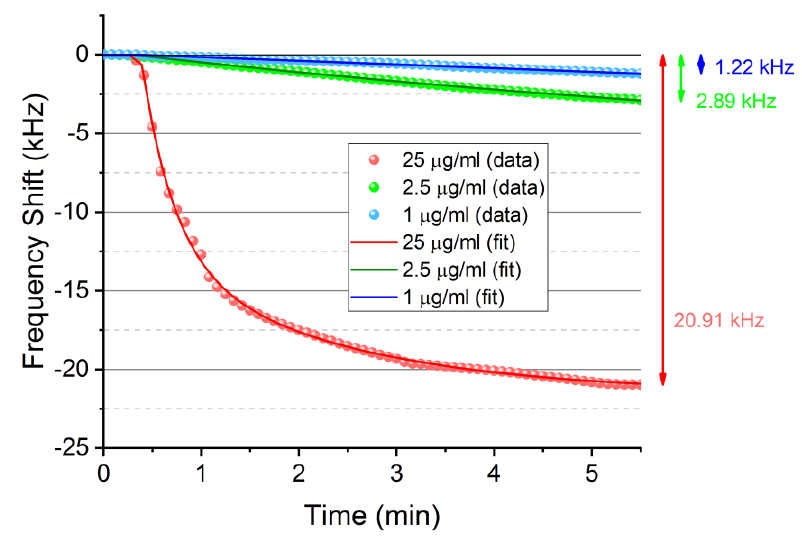
Figure 6. Responses for different concentrations of FGF-2.